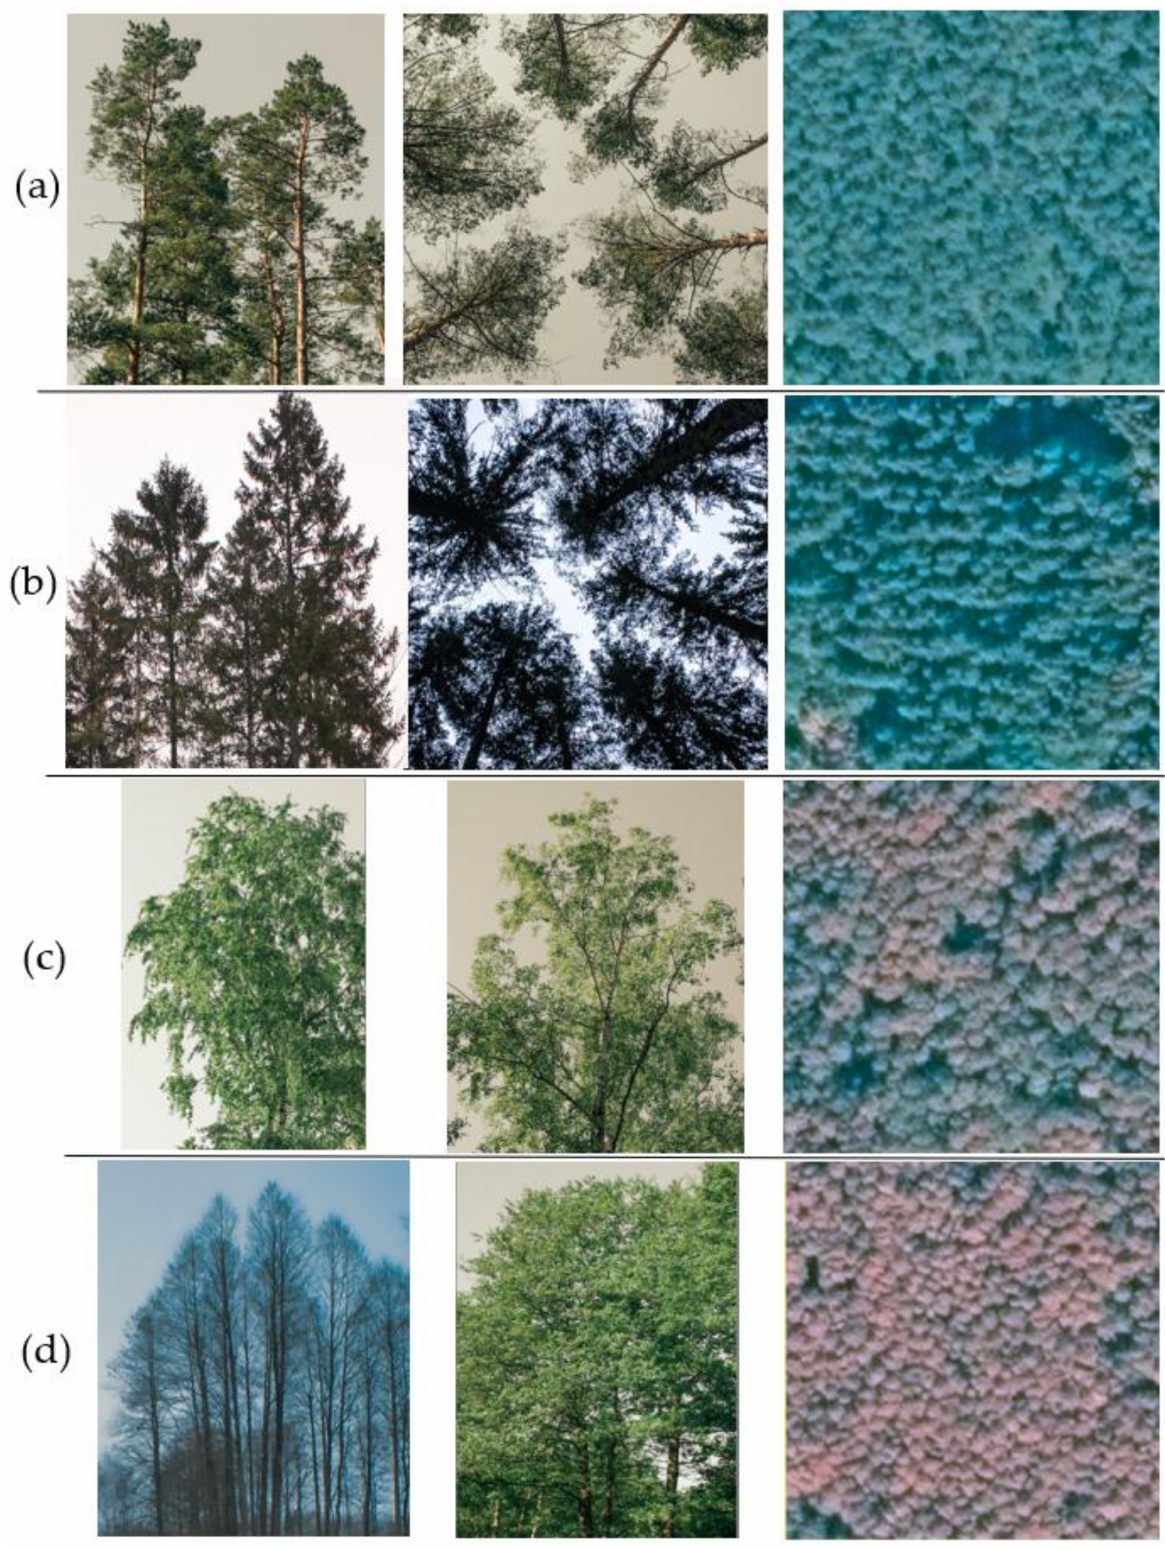
Figure 9. The four selected tree species of this study, ( a ) pine (Pinus sylvestris) , ( b ) spruce ( P í cea á bies ), both with vertical canopy profile and zenith views, ( c ) birch ( B é tula ), vertical canopy profile and oblique shot, ( d ) black alder ( Á lnus glutin ó sa ), vertical canopy profile leaf-off and leaf-on shots. The third column—GE1 backscattered imagery NIR-G-B fragments (1 ha) of related tree species in the study